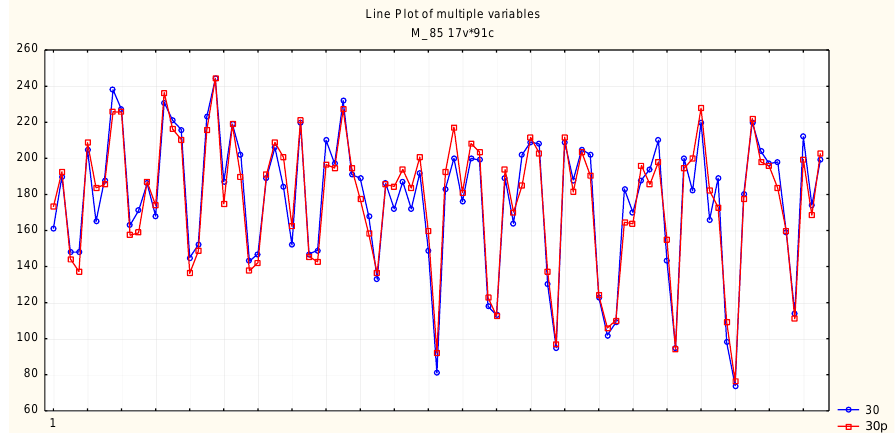
Fig. 14. Original and restored time series of passenger